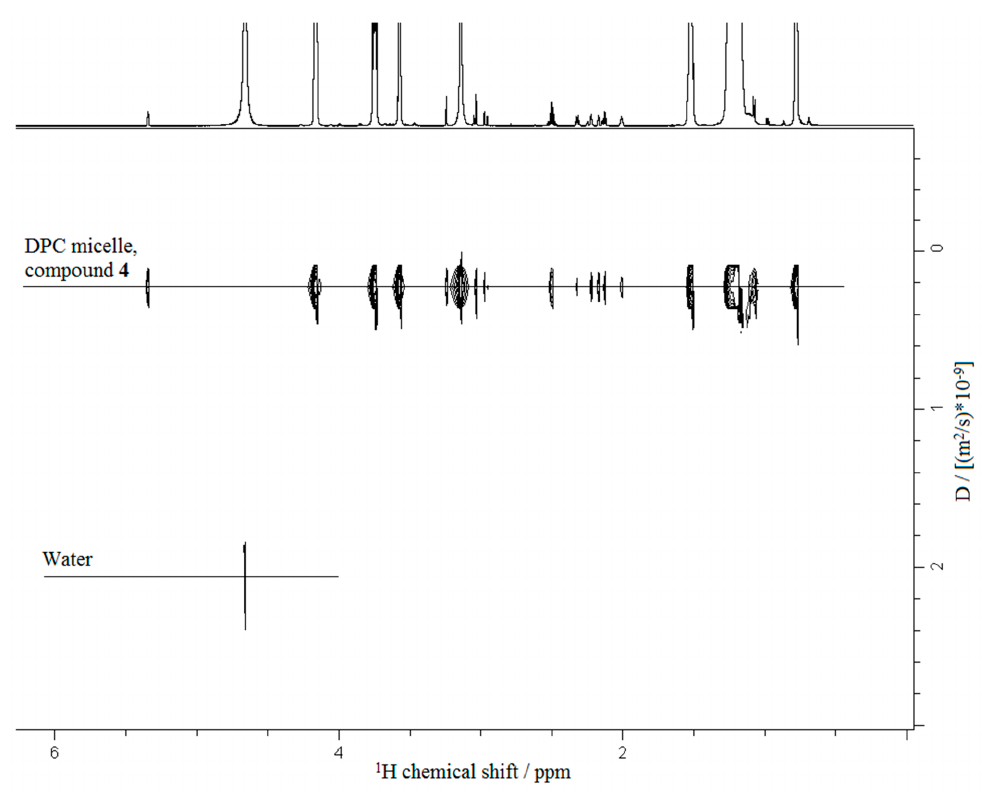
Figure 7. The 2D DOSY NMR spectrum of compound 4 in DPC/D 2 O solution at temperature 300 K.